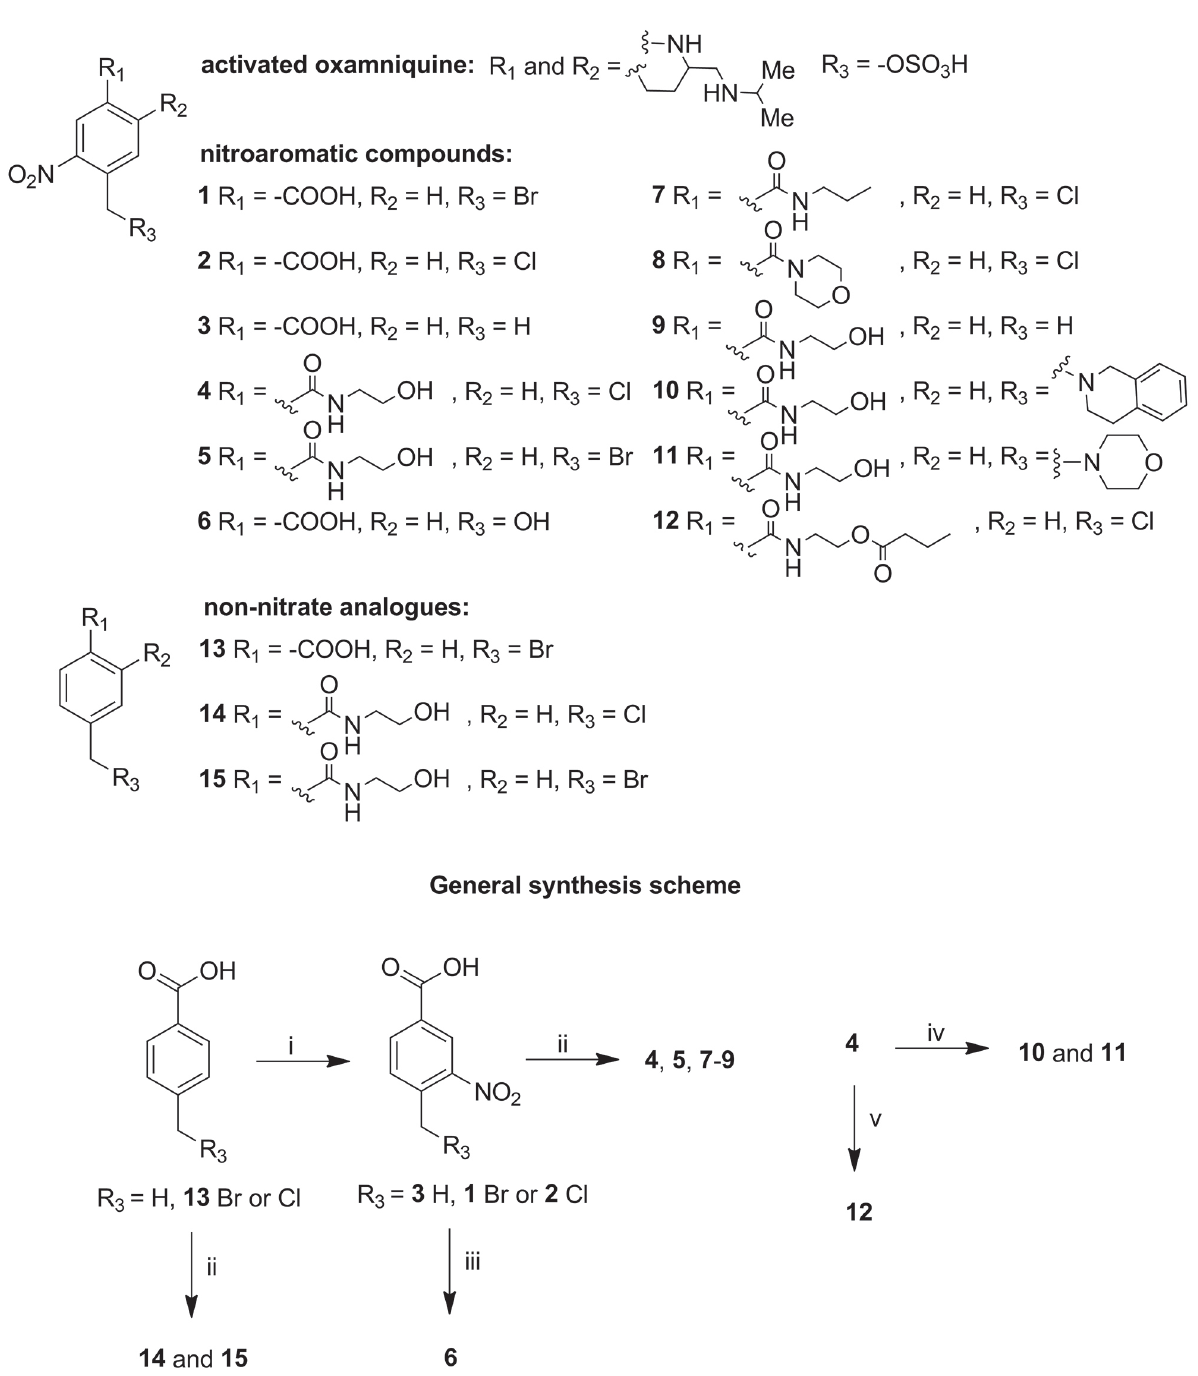
FIGURE 5 – Synthesized nitro-aromatic compounds and non-nitrate analogs and general synthesis scheme. Reagents and conditions: (i) fuming HNO3, 0 ºC, 51-87%; (ii) EDC, NHS, dichloromethane, rt or 0 ºC, then corresponding amines, 22-74%; (iii) NaHCO 80 ºC, 86%; (iv) tetrahydroisoquinoline (56%) or morpholine (64%), acetone, rt,; (v) butyric acid, EDC, DMAP, acetone, rt,